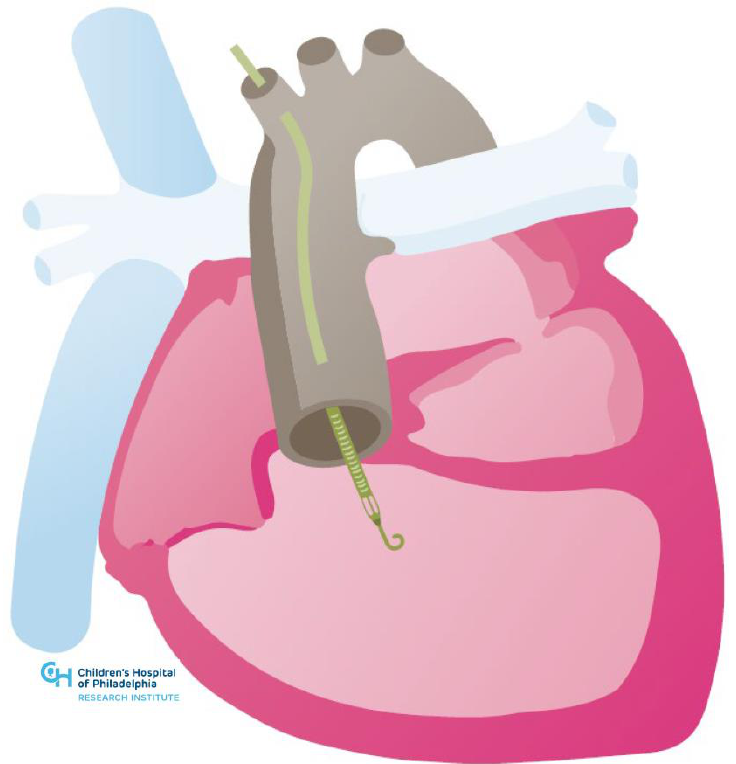
Figure 5. Illustration of Impella in hypoplastic left heart syndrome